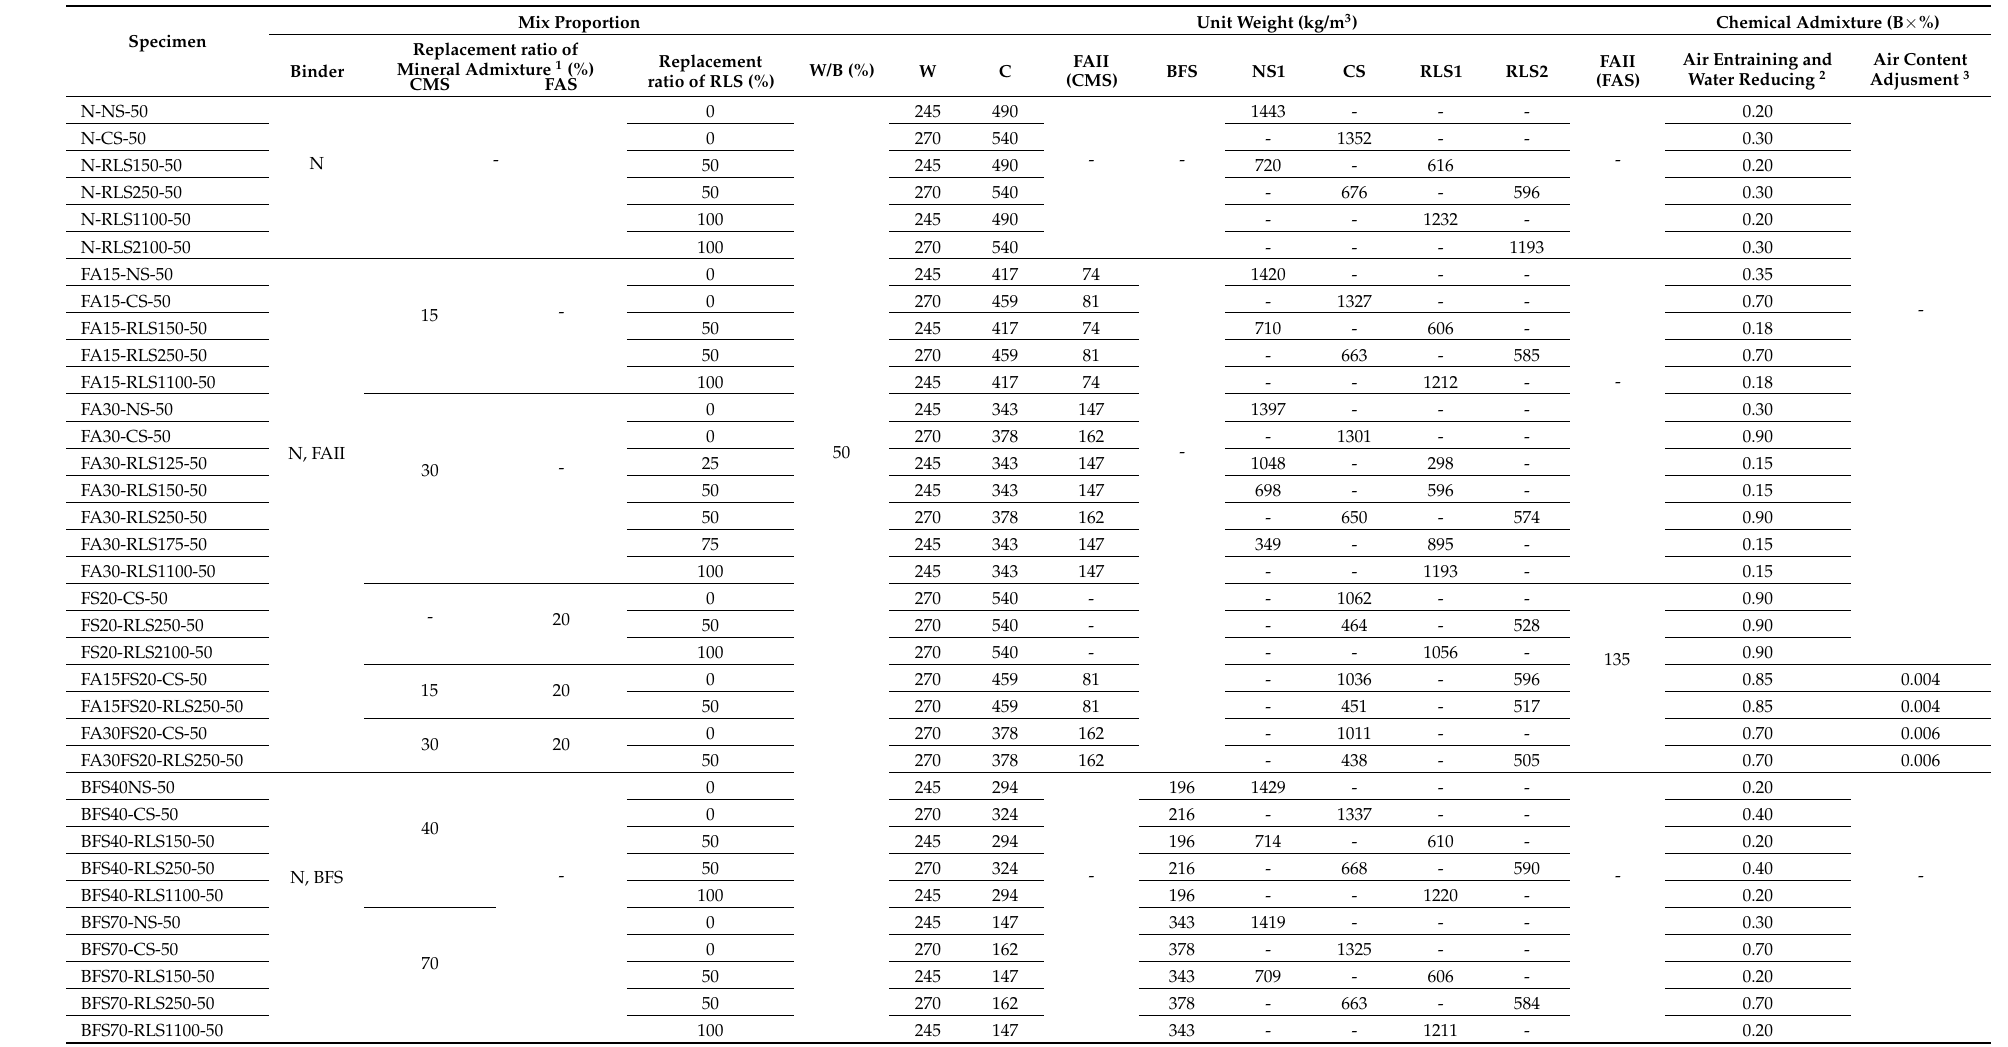
Table 5. Mortar mix